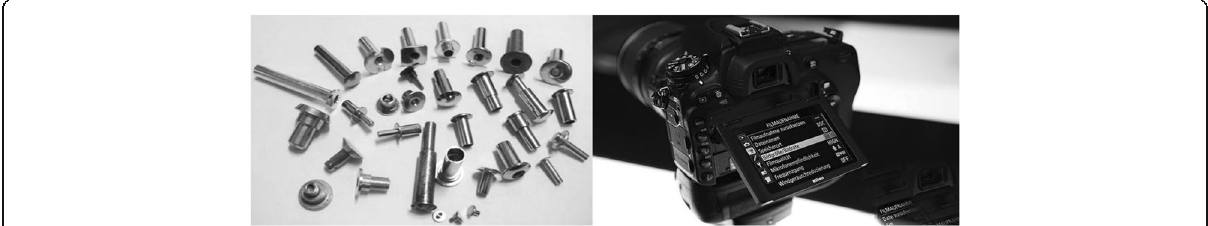
Fig. 1 Precision rivets of different sizes for experiments and photo acquisition equipment